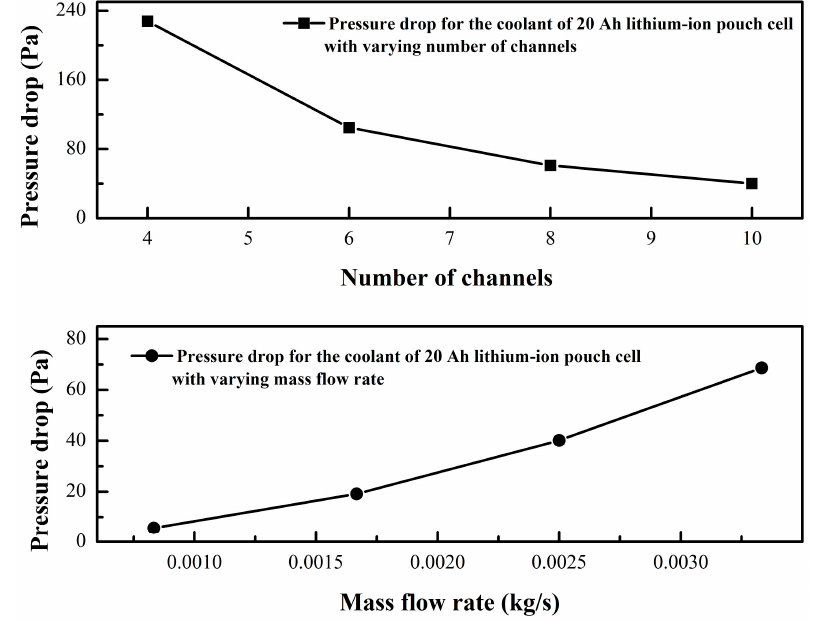
Figure 7. Pressure drop for the coolant of 20 Ah lithium-ion pouch cell with varying the number of channels and the mass flow